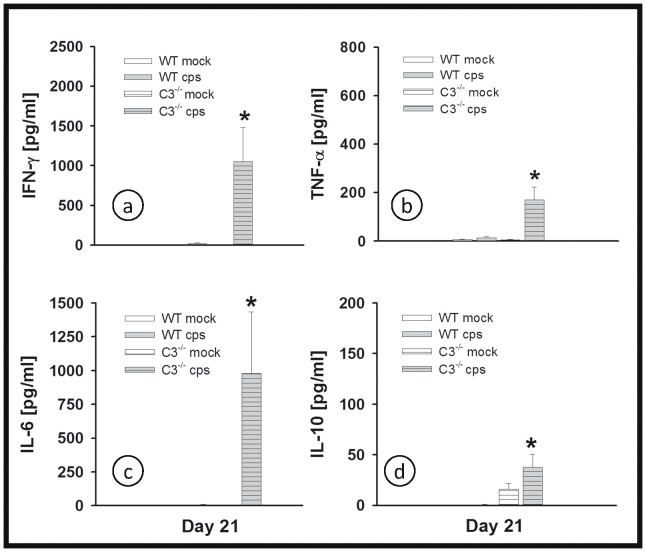
Figure
7. No indication of lack of cytokine response in the absence of complement in low-dose infection. Mice were infected with 200 IFU of C. psittaci DC15 or mock-infected. The cytokines IFN-γ, TNF-α, IL-6 and IL-10 (panel a-d) were determined in the lung homogenate of the animals sacrificed on day 21 p.i. The figure shows data obtained from C. psittaci-infected mice (cps, gray bars), mock-infected mice (white bars), WT mice (open bars) and C3−/− (horizontally hatched bars). * indicates significant (p<0.05) differences between infected knockout as compared to the corresponding infected BL/6J WT mice. Means ± SEM are depicted. * indicates significant (p<0.05) differences between infected knockout mice as compared to the corresponding infected BL/6J WT mice.